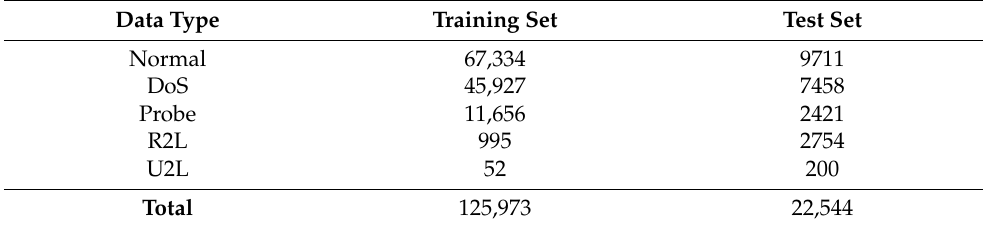
Table 2. Data type distribution table. Data Type Training Set Test Set Normal 67,334 9711 DoS 45,927 7458 Probe 11,656 2421 R2L 995 2754 U2L Total 125,973